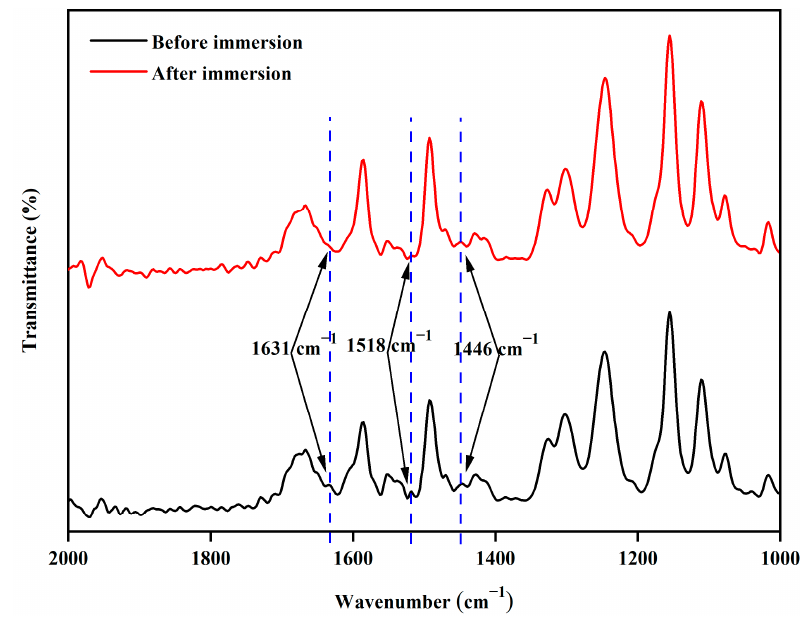
Figure 17. FTIR spectra of PES–DPS–1 before and after chlorine immersion (Blue dashed lines are intended to help locate the corresponding absorption